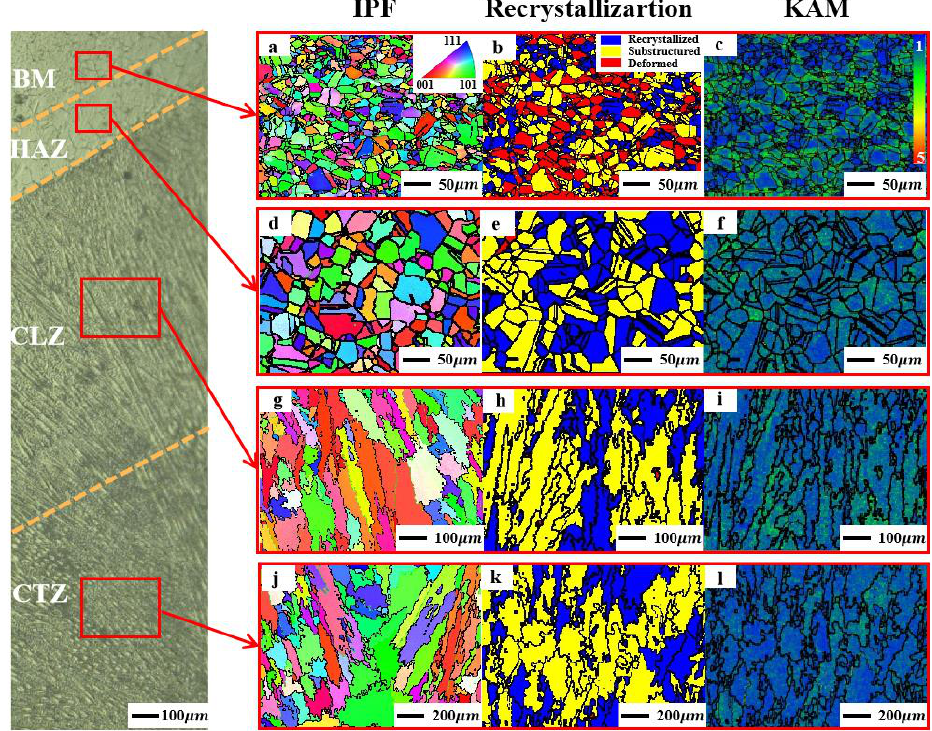
Figure 5. The IPF, recrystallization diagram, and kernel average misorientation (KAM) diagram of different areas of the sample after 740 mA electron beam scanning: ( a,b,c ) BM, ( d,e,f ) HAZ, ( g,h,i ) CLZ, ( j,k,l ) CTZ.